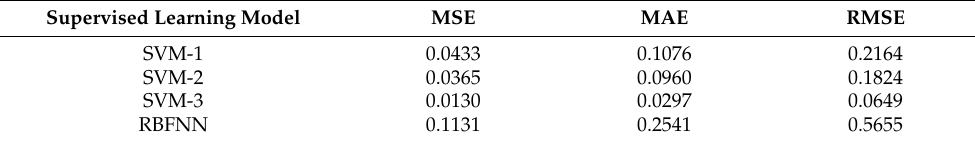
Figure 7. Error Indices. Table 5. Comparison of Error